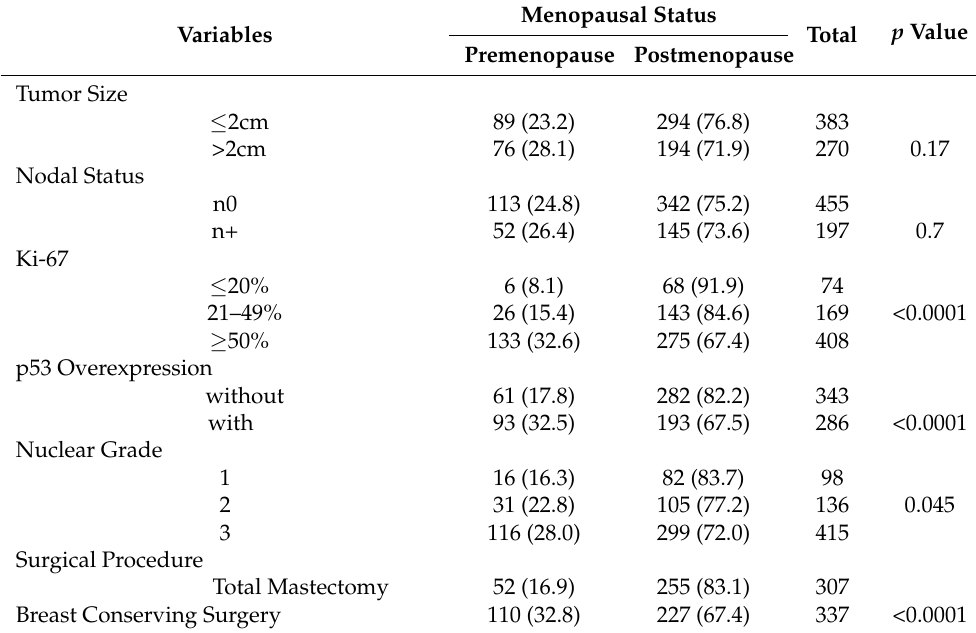
Table 2. Clinicopathological Characteristics and Menopausal Status in TNBC.